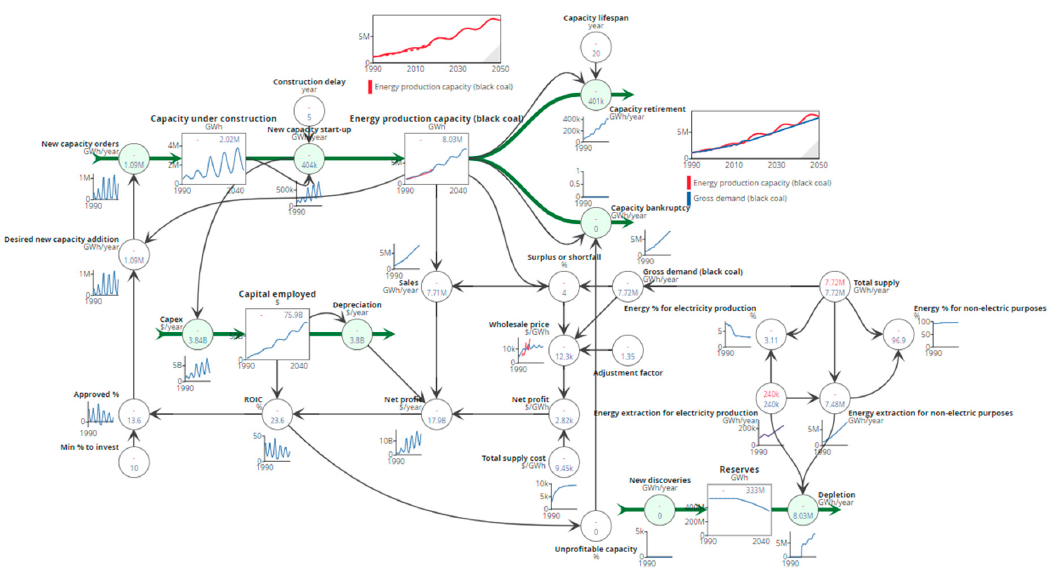
Figure 3. Energy resources extraction pipeline model for dispatchable resources.